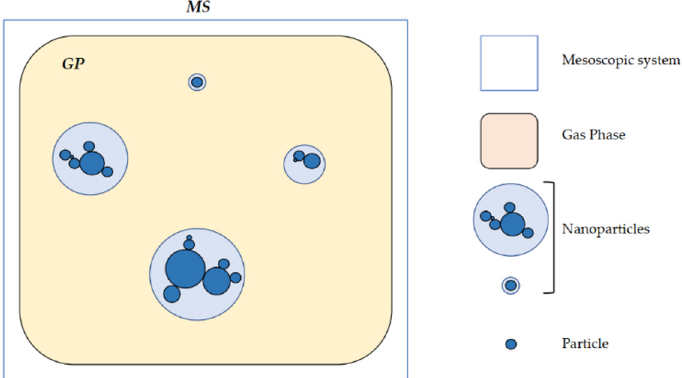
Figure 2. Mesoscopic system schematization.